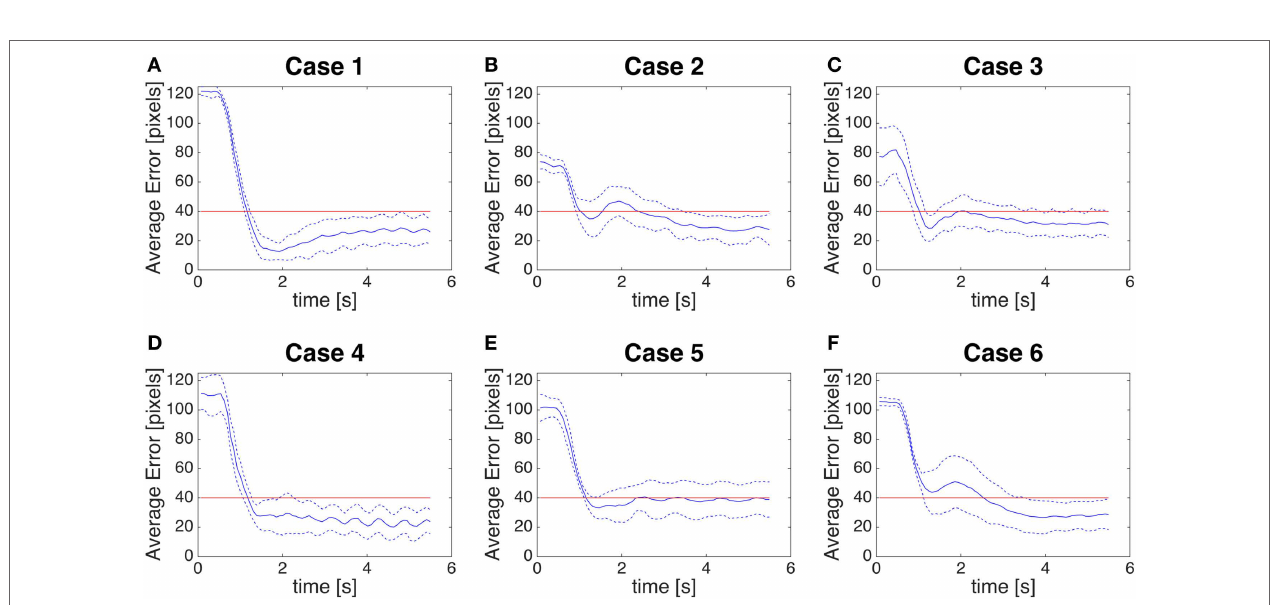
FIGURE 11 | (A–F) Global error. Distance between the centroid of the biological motion (given by color segmentation) and the fovea (0,0). The blue line is the average error, the blue dotted line is the average error (cid:6) SD. The red line is a threshold of 40 pixels.